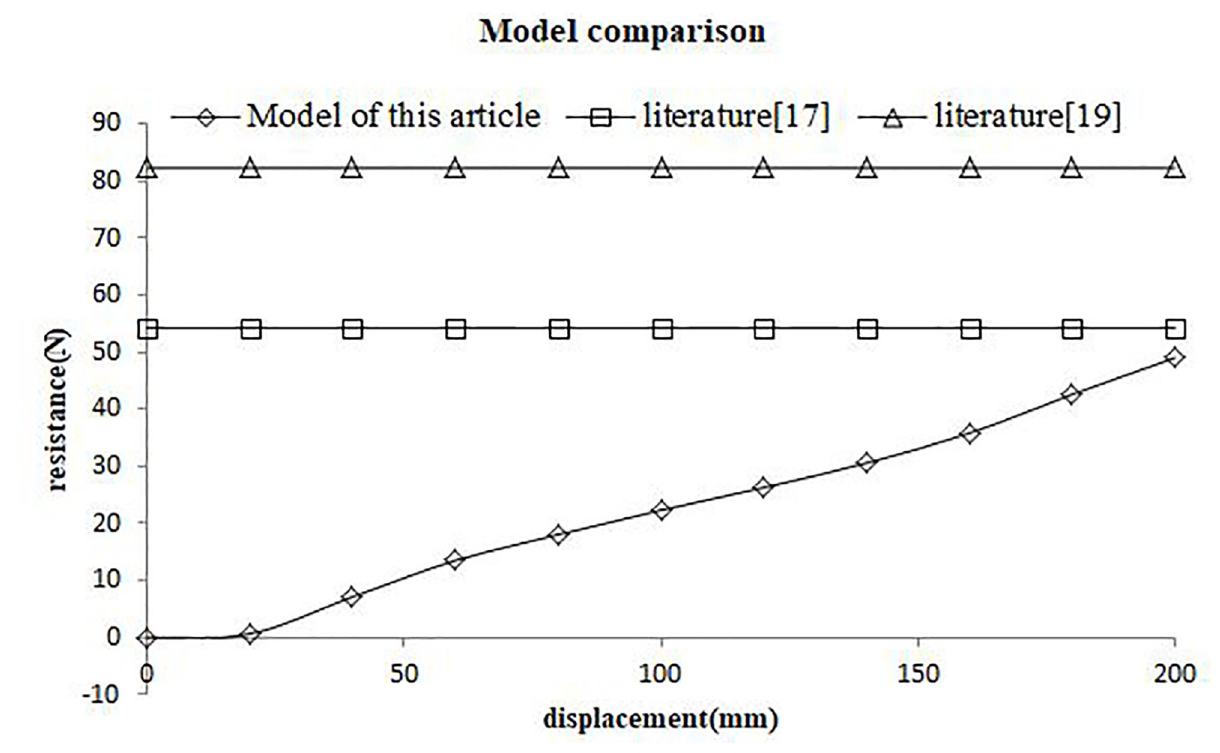
Fig 6. Model comparison